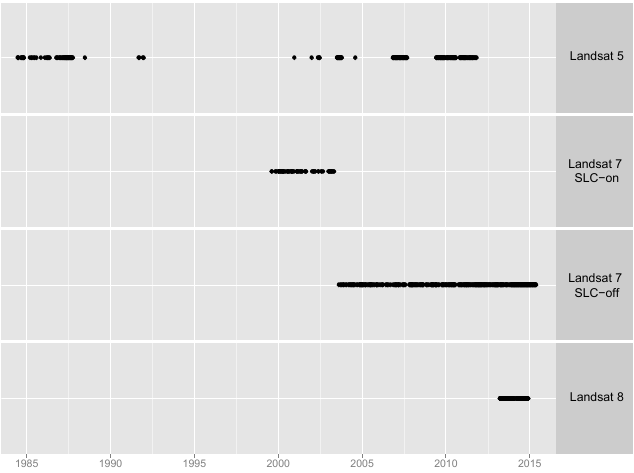
Figure 4. Availability of Landsat images for the Merguellil upper catchment.